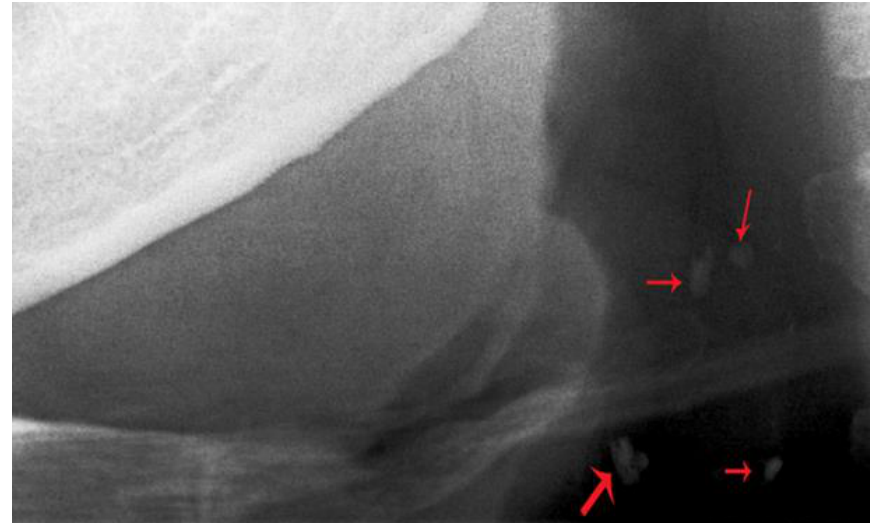
Figure 2. Close-up view of a panoramic radiograph showing the radio-opacities in the carotid vasculature. Red arrows indicate carotid artery calcifications.